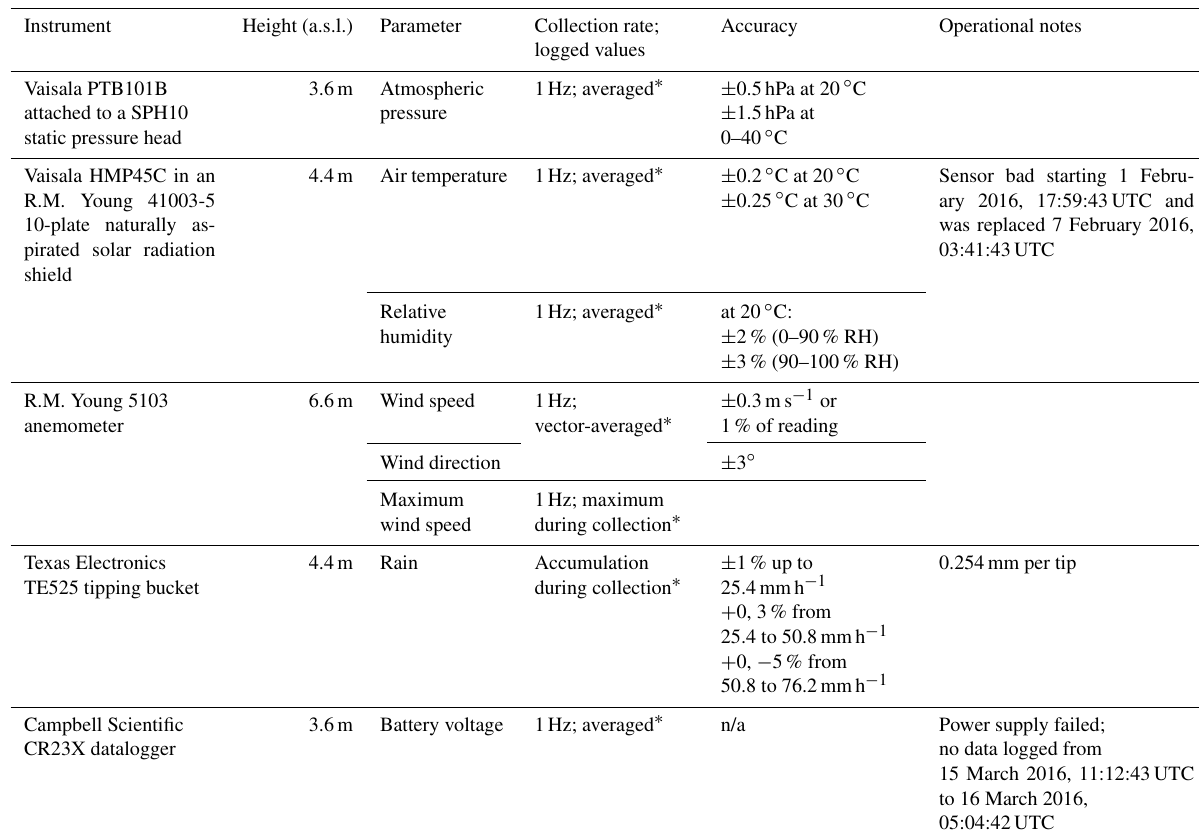
Table 1. Surface meteorology instruments deployed at Kiritimati Island during the ENRR field campaign. Instrument Height (a.s.l.) Parameter Collection rate; Accuracy Operational logged values